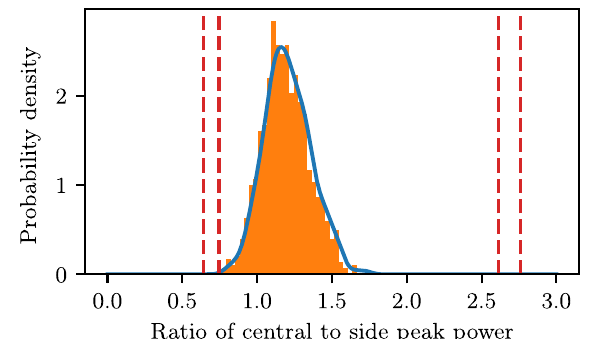
FIG. 10. A histogram of ratios of the power in the central axion peak (colored orange in Fig. 9) relative to the average power of the side peaks (colored green and red in Fig. 9) based on Monte Carlo simulations for a signal candidate at 6.666 75 Hz. From the Monte Carlo simulations, this ratio should be centered at approximately 1.2 for a true axion signal. The solid blue line shows a smoothed distribution of the ratio. Red lines indicate the experimental ratios for the four peaks near 6.666 Hz shown in the inset of Fig. 8. Given their distance from the Monte Carlo distribution, we can conclude with > 90% con- fidence that these peaks are not